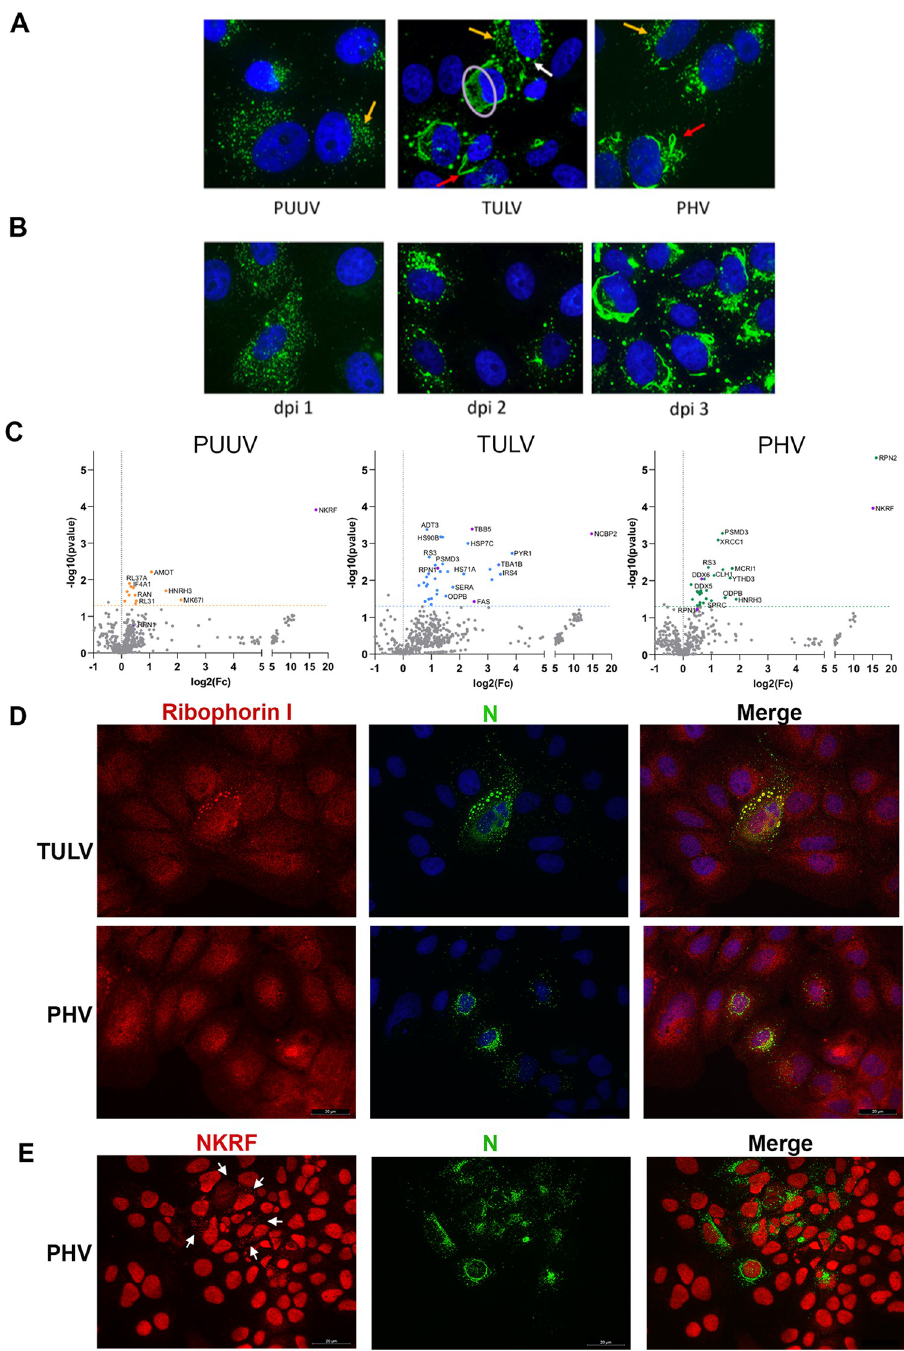
Fig 6. Interaction of the nucleocapsid of PUUV, TULV and PHV with cellular proteins. Panel (A) shows the different organizations of PUUV-N, TULV-N or PHV-N, identified by intracellular detection at dpi 3 in infected Vero E6 cells (green staining). Small dots of N protein are marked with yellow arrows, filaments with red arrows, bigger granules with white arrows and aggregates are circled in pale purple. Nuclei are counterstained with DAPI (blue staining). In (B), kinetics of TULV-N distribution is shown at dpi 1, 2 and 3. In (C), interactors of the N of PUUV, TULV and PHV identified by mass spectrometry analysis are shown. Cellular partners, statistically significant (p- value < 0.05), are colored in orange, blue and green for PUUV, TULV and PHV, respectively. Further explored interactors are colored in violet. In (D), HuH7 cells were infected with TULV or PHV at a MOI of 0.5 and stained for ribophorin I (red) and viral N (green). Co-localization appears in yellow in the merge panel. In (E), HuH7